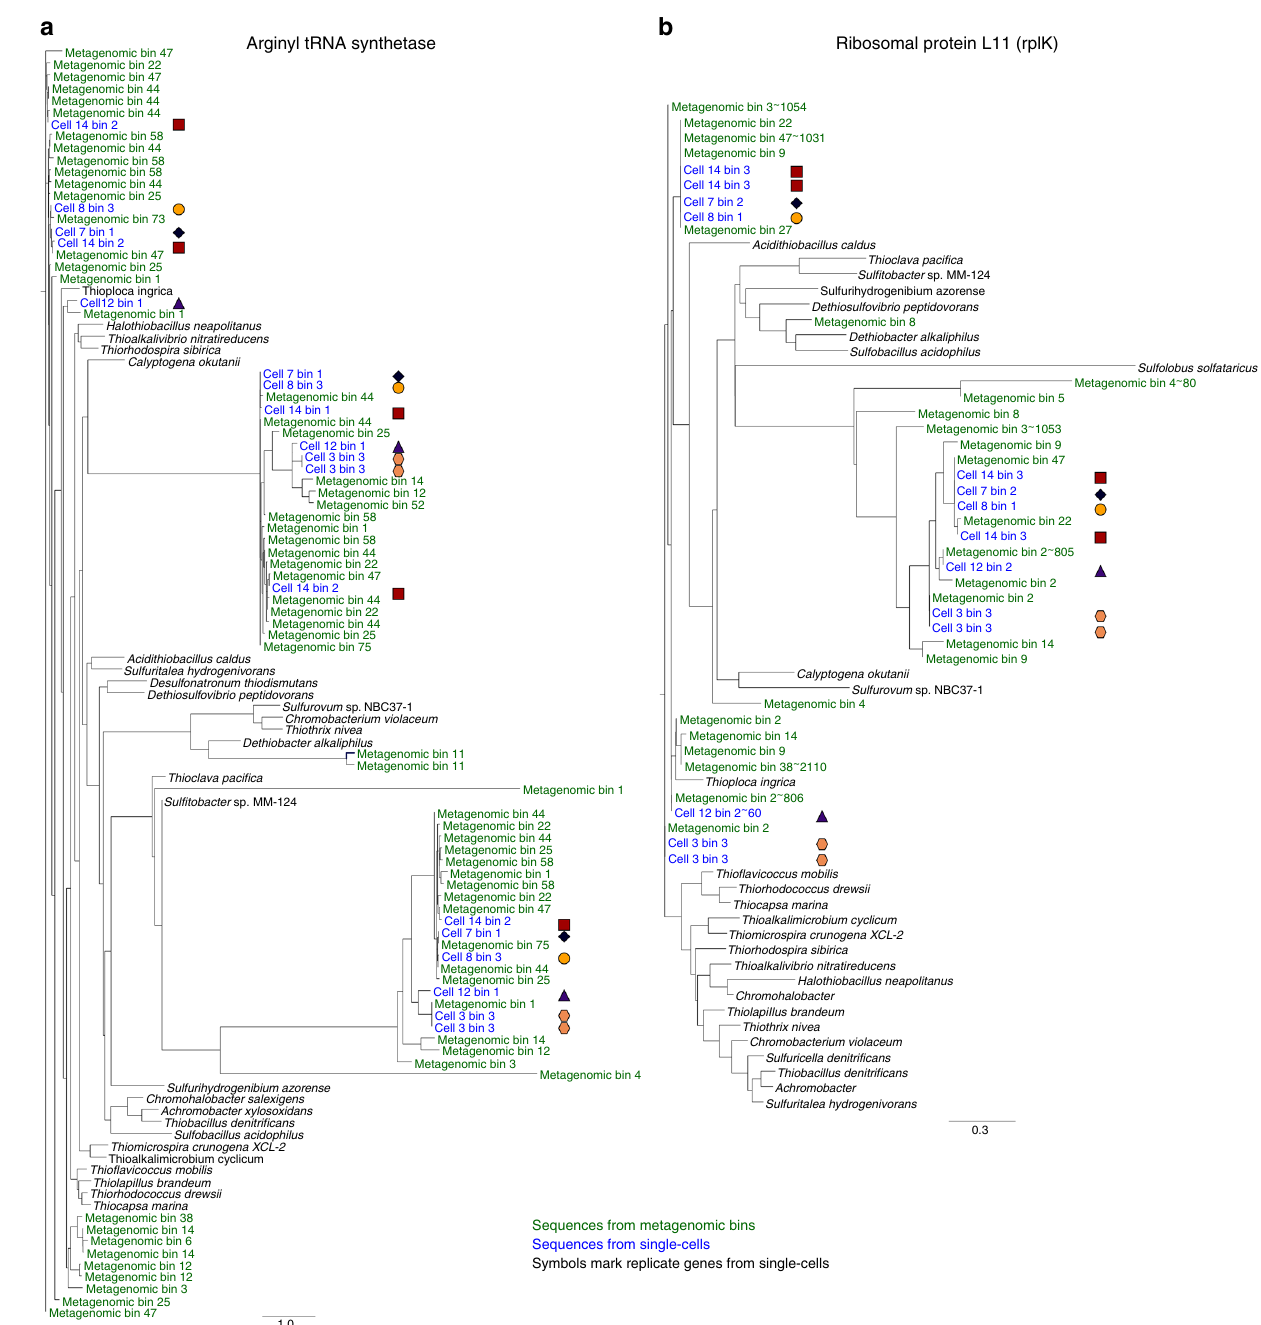
Fig. 5 Maximum likelihood tree of two proteins believed to be single-copy marker genes. The genes encode Arg-tRNA-synthase a and ribosomal protein L11 (rplK) b . Replicate copies of the genes identi fi ed in the same cells are marked by identical shapes. Additional trees of “ single copy ” marker genes (protein trees) are given in Supplementary Data